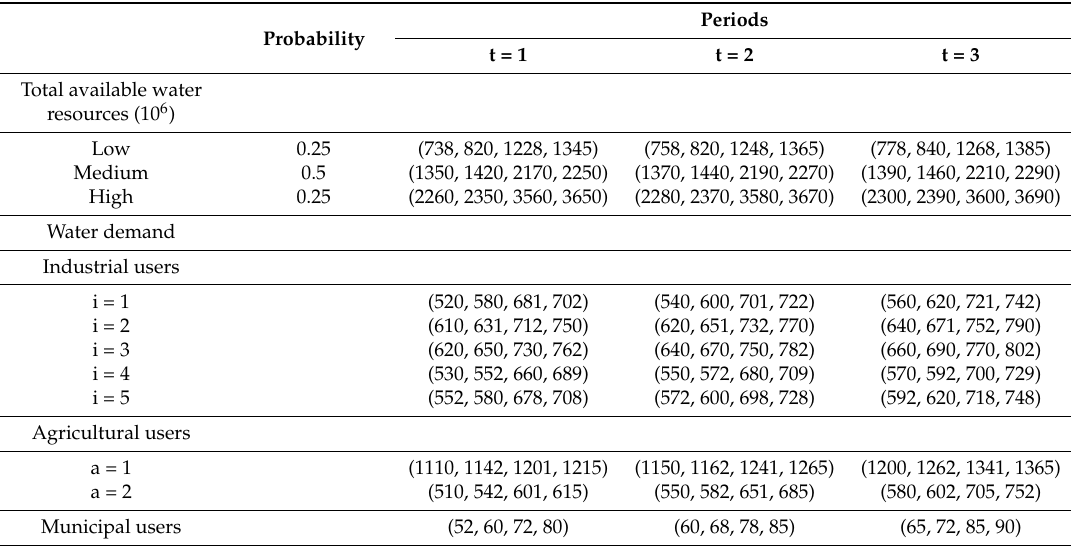
Table 2. Available and demand water with T2 fuzzy features under different inflow